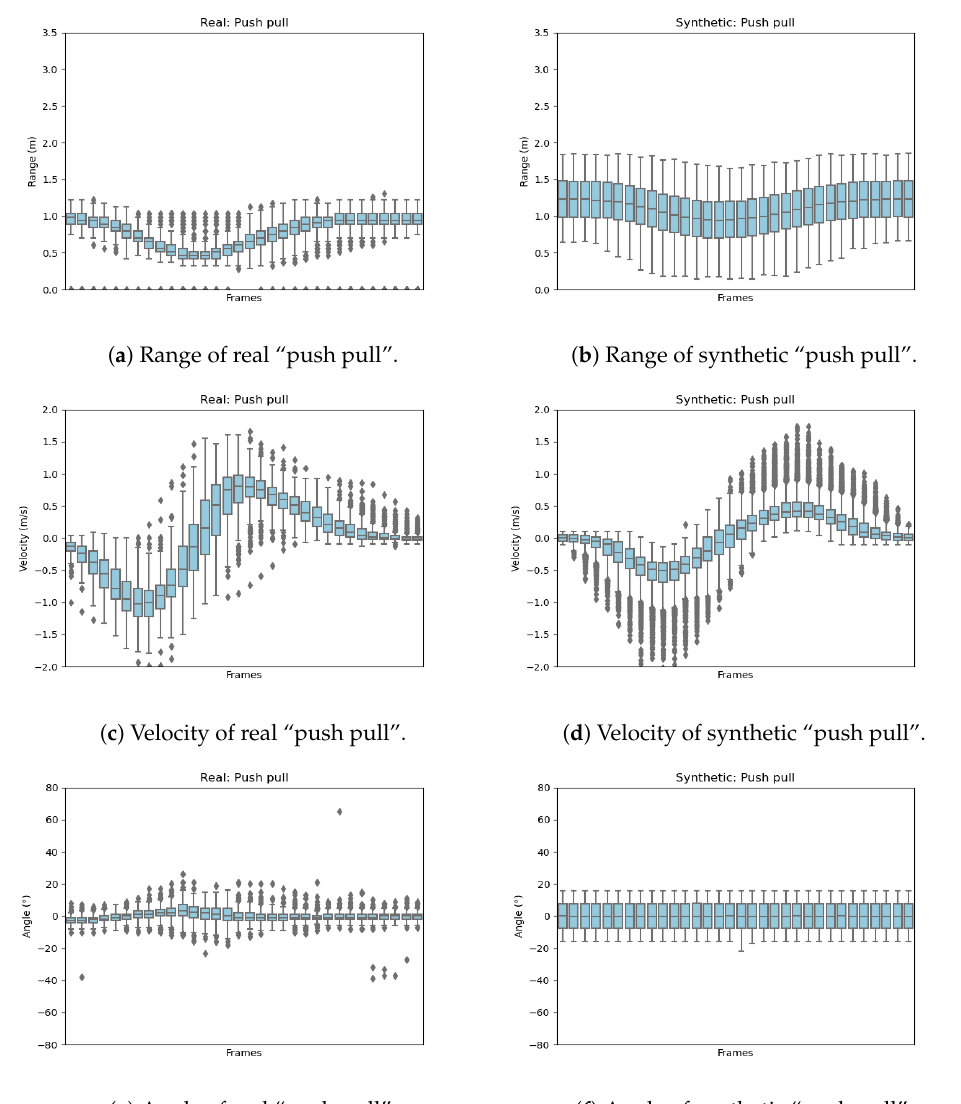
Figure 11. Box-plot for feature distribution of real and synthetic “push